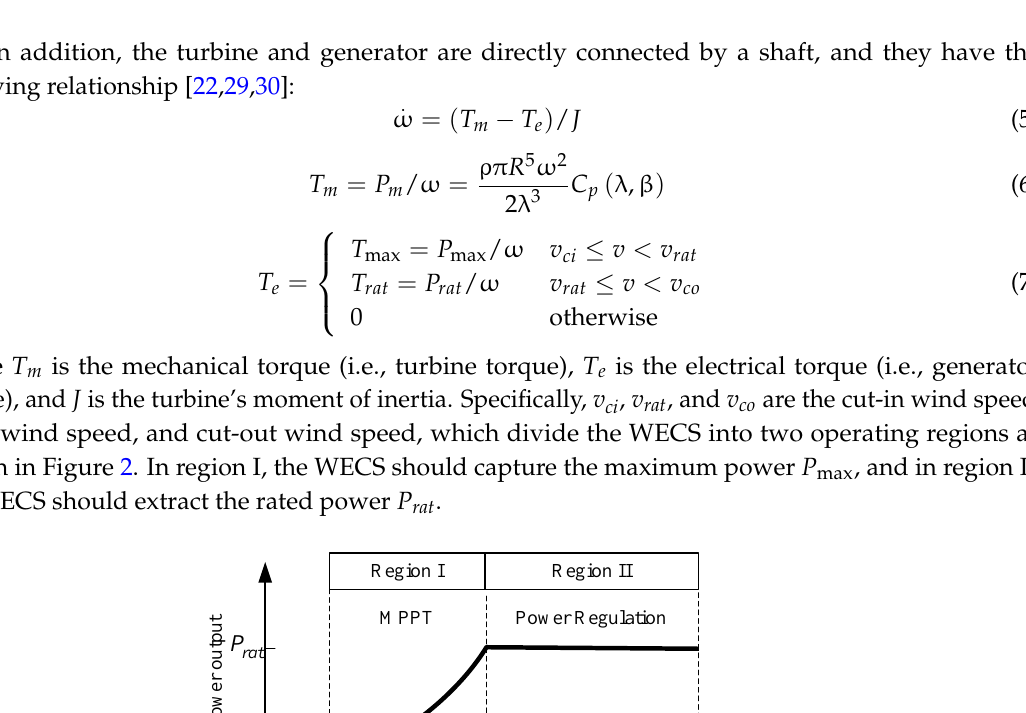
Figure 1. A typical wind energy conversion system.